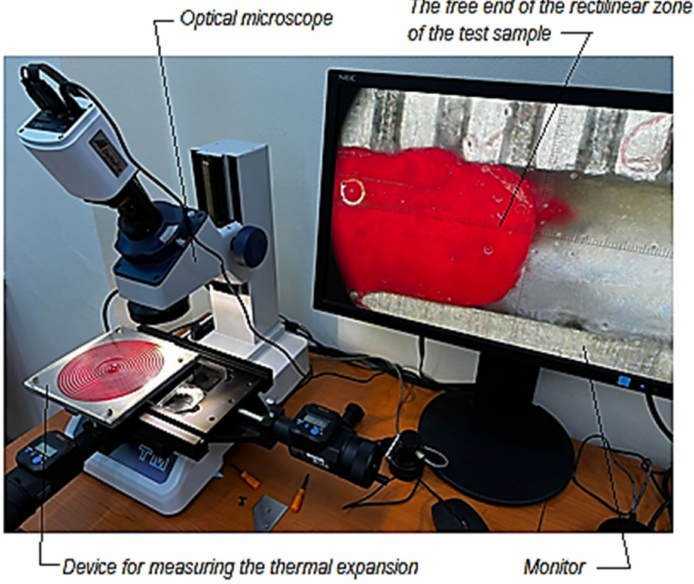
Figure 2. Image of the device for measuring the thermal or negative thermal expansion of the spiral test sample made of polymeric material Flexifill 98A, in the variant involving an optical